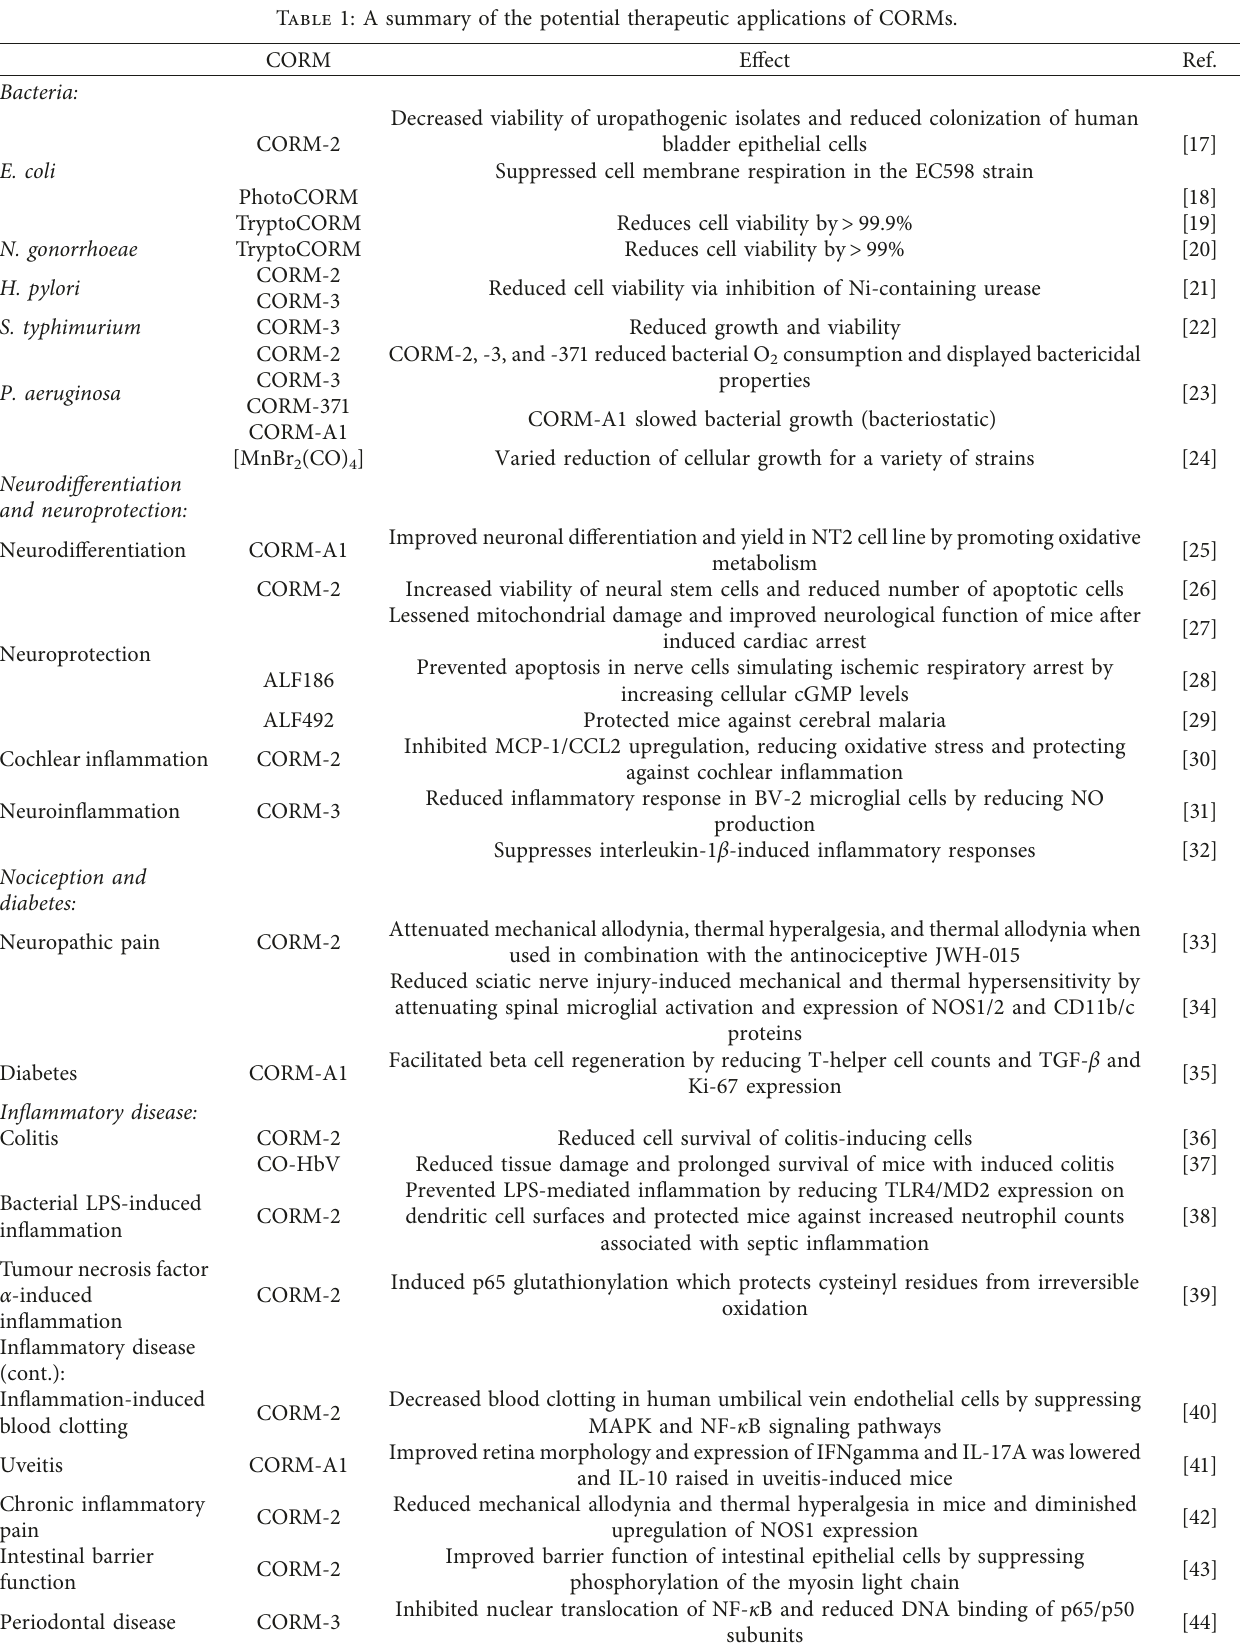
Table 1: A summary of the potential therapeutic applications of CORMs. Effect